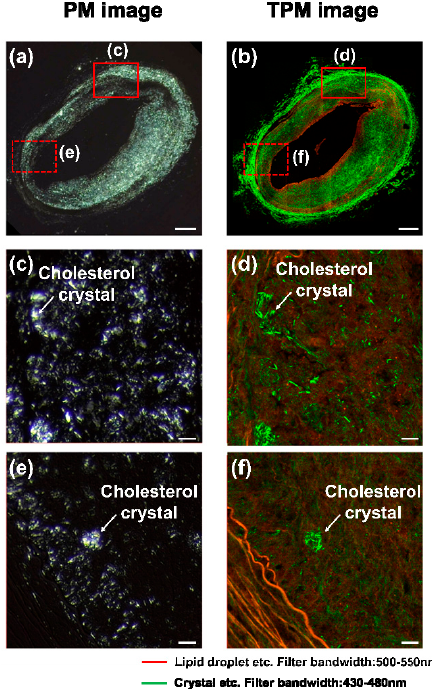
Figure 5. Polarization microscope (PM) image (left column) and two-photon microscope (TPM) image (right column). A sectioned rabbit artery sample imaged by using ( a ) PM and ( b ) TPM. Highly magnified images of the sample by using ( c , e ) PM and ( d , f ) TPM. Scale bars: ( a , b ) 500 μ m and ( c – f ) 20 μ m.